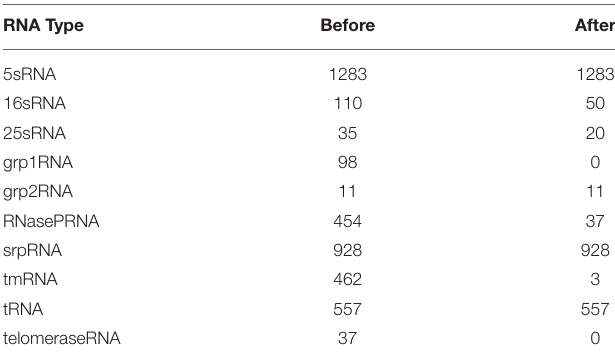
TABLE 3 | The number of RNAs in each data set before and after the pseudo-knot was removed. RNA Type